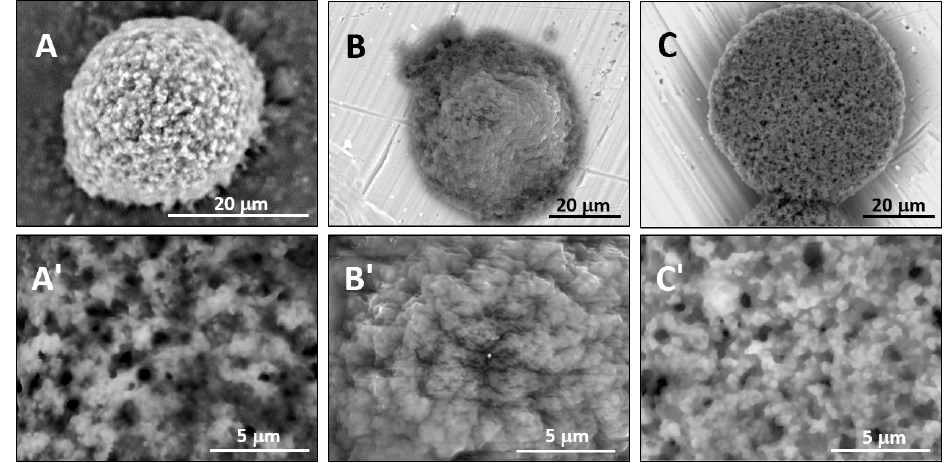
Figure 5. SEM micrographs of the PNIPA-FA hydrogel spheres filled with water ( A , B ) or ionic liquid ( C ) and deposited on the carbon ( A ) or aluminum ( B , C ) substrates of the SEM